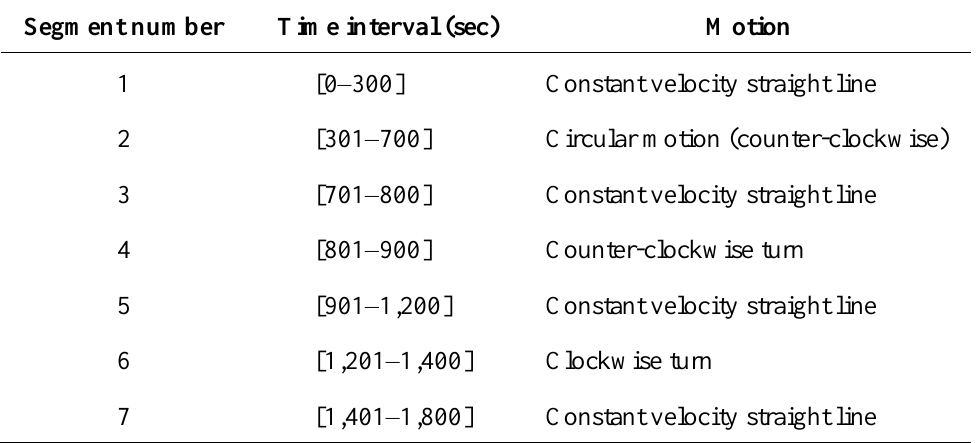
Table 1. Description of the vehicle motion.